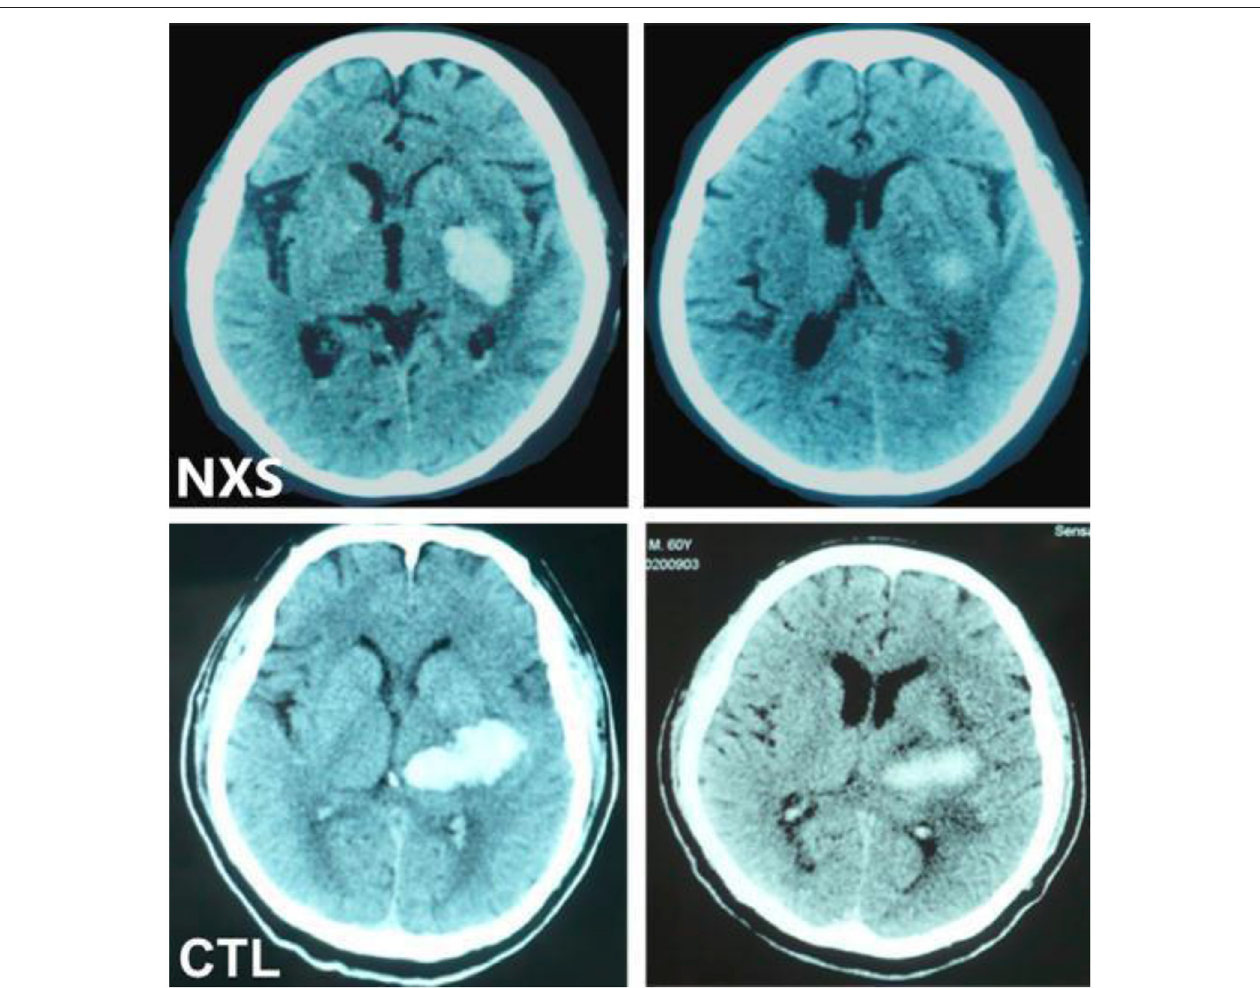
FIGURE 1 | Comparison of changes in hematoma volume between two patients. Left : pre-treatment; Right : post-treatment; Representative CT images of hematoma absorption progress from hemorrhagic stroke patients with or without Naoxueshu treatment. Both patients, at age of 71 (Naoxueshu group, NXS) and 68(Control group, CTL), were admitted as acute hypertensive intracerebral hemorrhage, with hematoma volume of 25ml (NXS group) and 26ml (CTL group) and received regular therapy, with (NXS group) or without (CTL group) supplementary Naoxueshu treatment. Naoxueshu oral liquid promoted the hematoma absorption after a 21-day